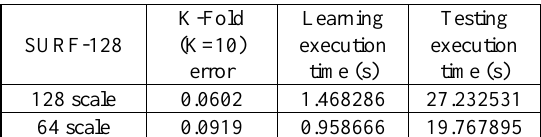
Figure 2. The separation with the green line (J statistic) between positive and negative features for the 64 scale The SVM was learning was validated using 10 folds cross- validation on the learning set. The following table showed the error and execution times for each scale.